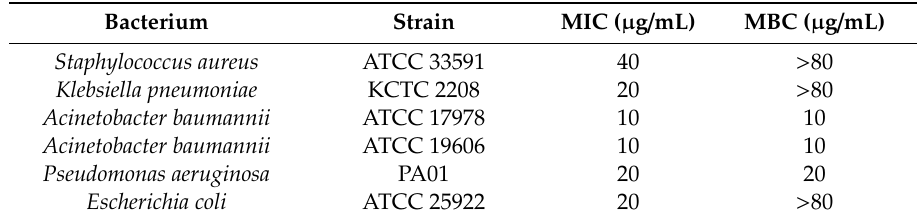
Table 1. Minimum inhibitory concentrations (MICs) and minimum bactericidal concentrations (MBCs) of LysSAP26 against representative bacterial